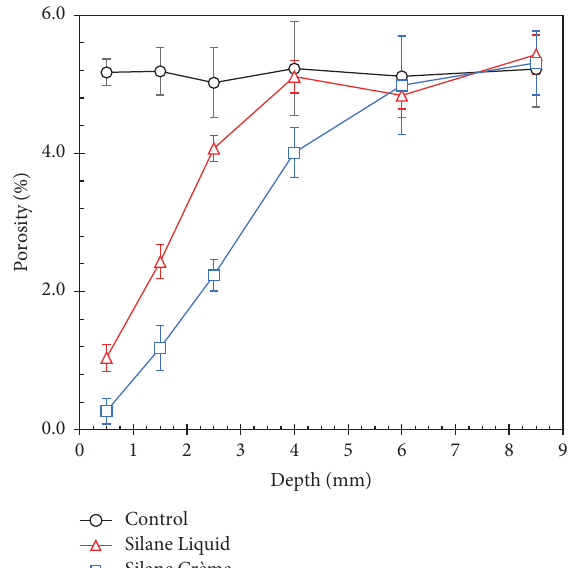
Figure 7: Porosity distribution from treated surface for the surface treatment determined by the BSE image analysis.